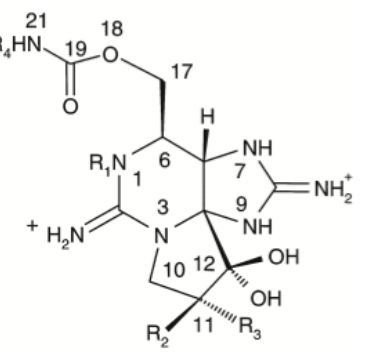
Figure 1. Chemical structures of saxitoxin (STX)-group toxins identified in contaminated dinoflagel- lates and molluscs. R indicates the substituted radical for each analogue.